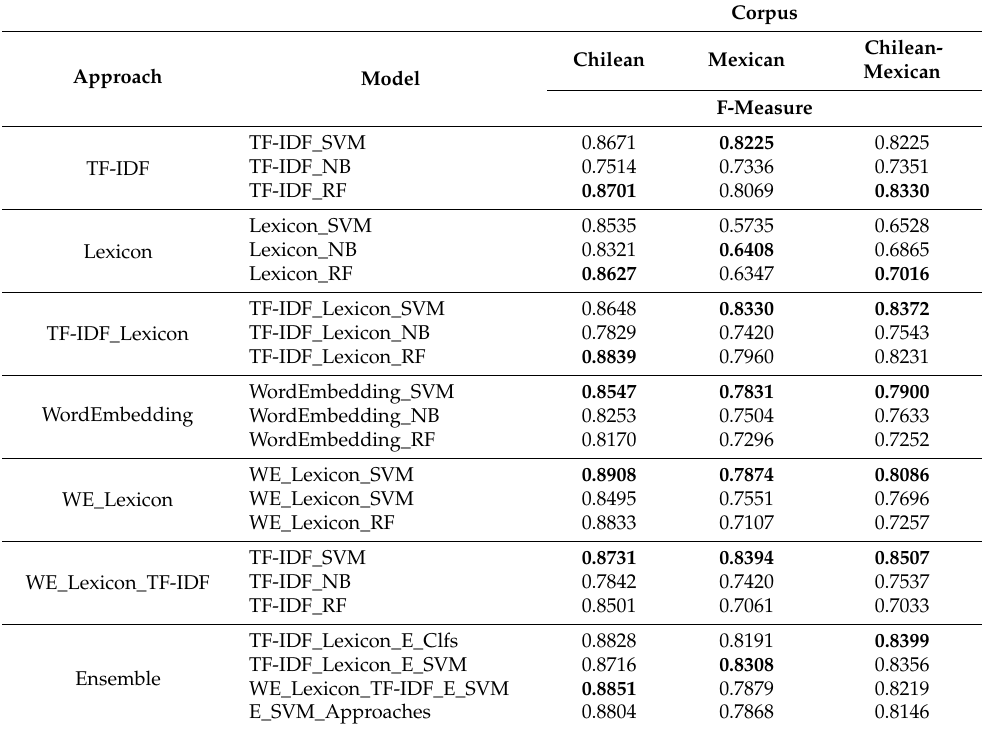
Table 6. F-measure obtained by the models in the corpus.